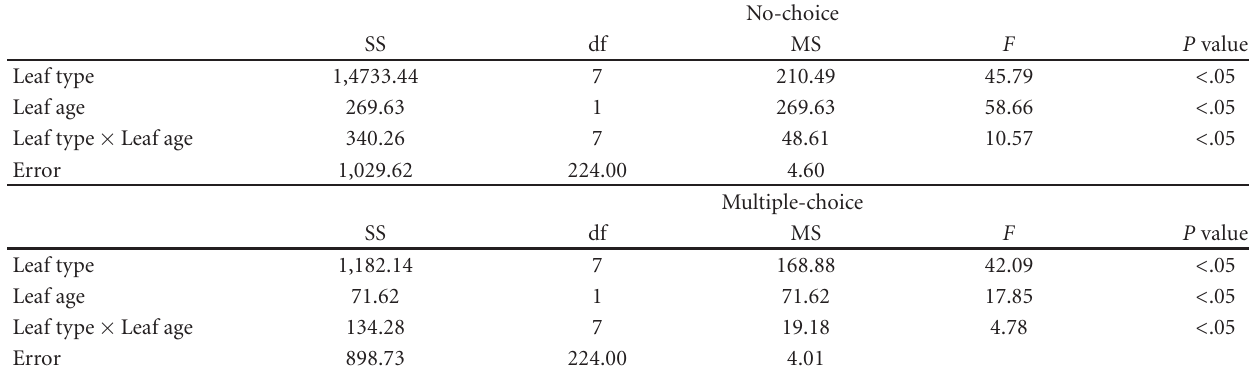
Table 2: Two-way ANOVA for feeding preference of L. tristis with respect to the leaf type and leaf age in no-choice and multiple-choice experiment tests.